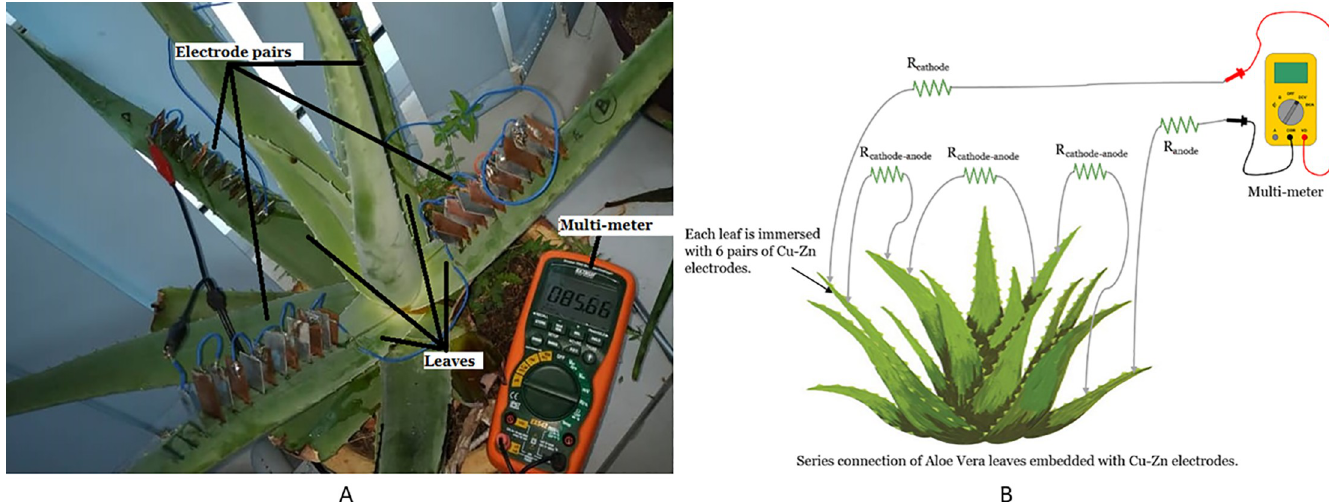
Fig 5. Experiment setup for series connection between leaves. Example of setup arrangement (A) and simple schematic of the setup (B).